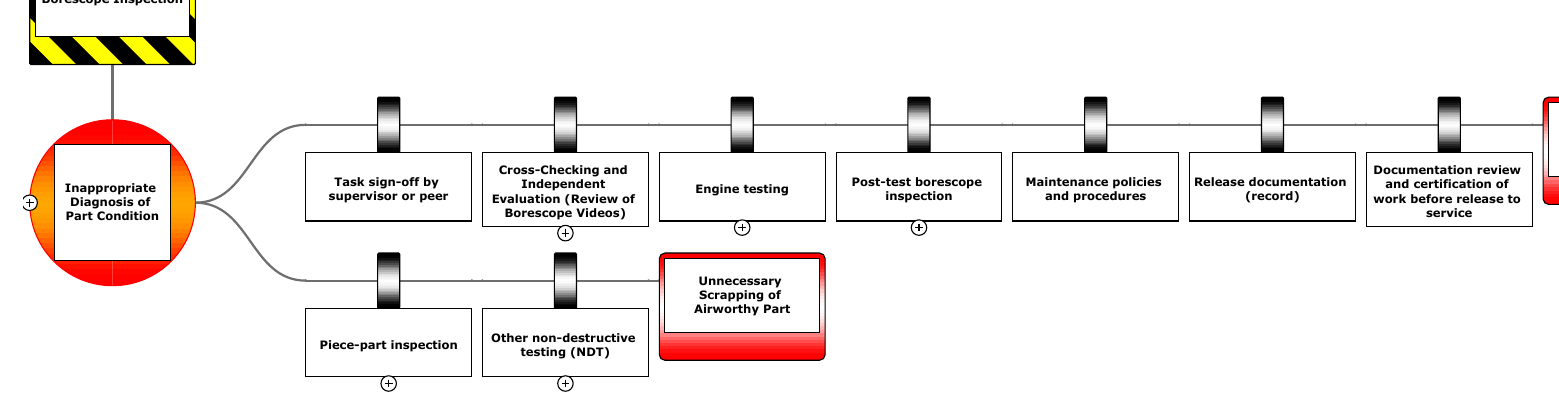
Figure A3. Consequence side of the Bowtie diagram with recovery barriers.